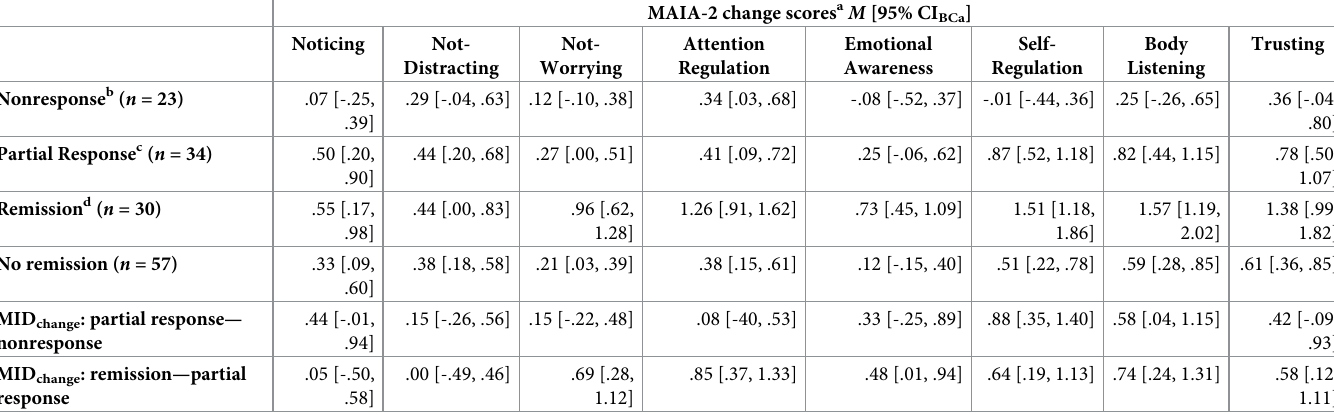
Table 6. Mean change scores of MAIA-2 and anchor-based minimal important difference stratified by treatment response ( n = 87).